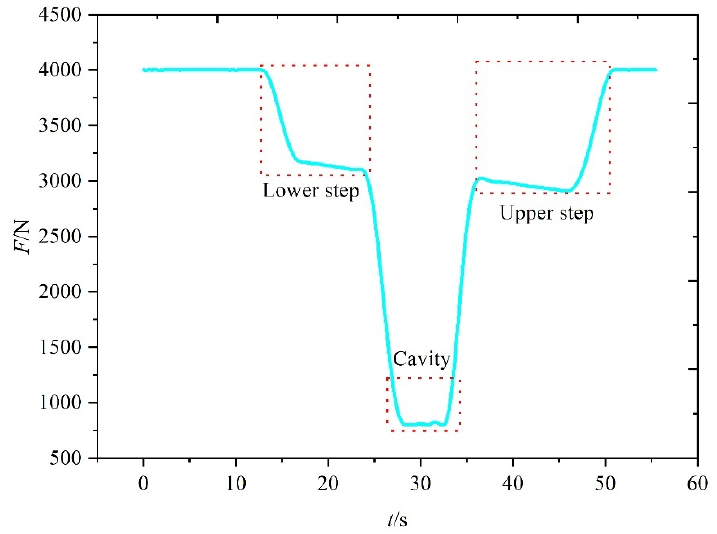
Figure 7. Thrust in the first scenario vs. time.